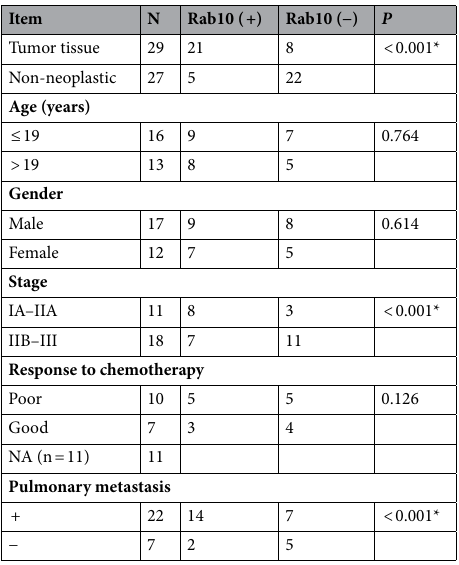
Table 2. Expression of Rab10 and clinicopathological characteristics in OS patients. NA not available. *Statistical significance was found with the Chi-square test/Chi-Square Goodness-of-Fit